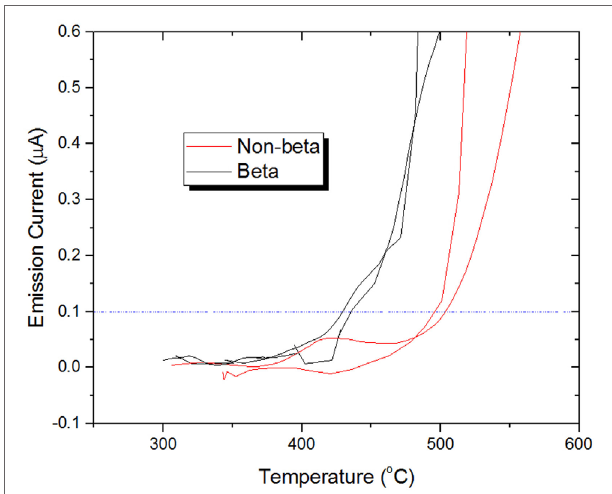
FigUre 6 | Example characteristic emission current as a function of temperature in the threshold region for a sample in set B, with (black line) and without (red line) beta radiation exposure. The blue dashed line shows the current threshold considered to be thermionic